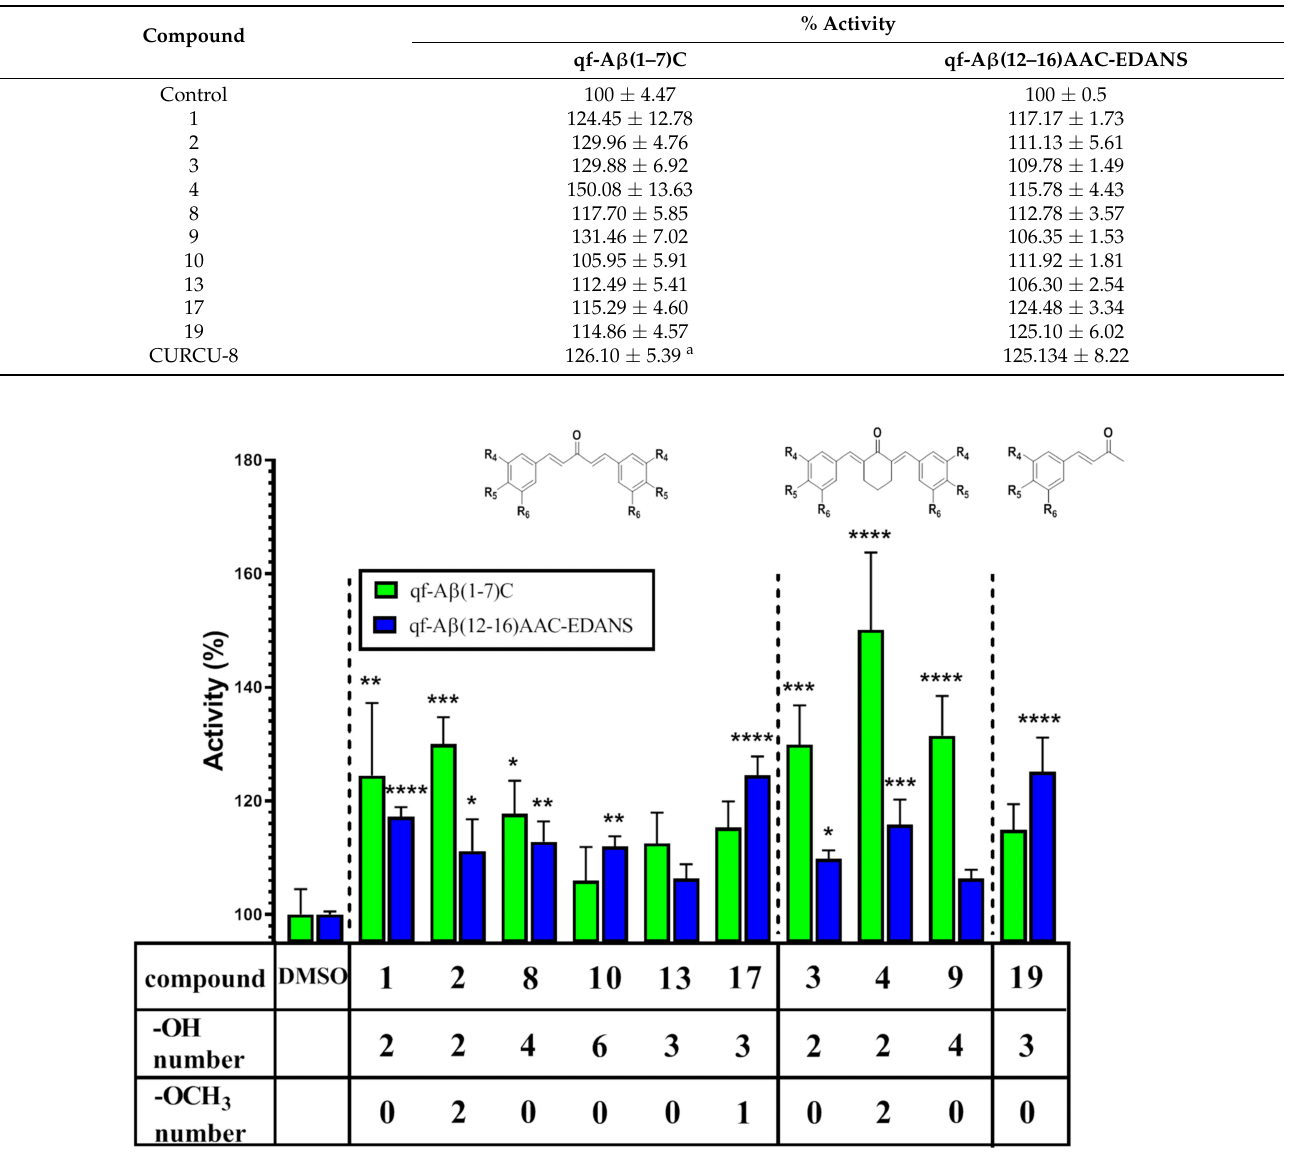
Figure 4. A β -degrading activity assay in SH-SY5Y cells incubated for 24 h using qf-A β (1–7)C or qf-A β (12–16)AAC-EDANS as substrate with 0.5% DMSO (control) or in the presence of the tested compounds (5 µ M). The data are the mean ± SD for three independent samples. * p < 0.05; ** p < 0.01; *** p < 0.001; ****, p < 0.0001 compared to the control by one-way